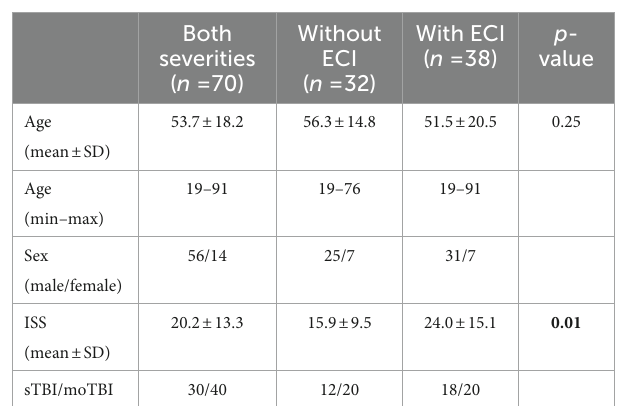
TABLE 1 Demographics of moderate and severe TBI subgroups and subgroups of patients with/without